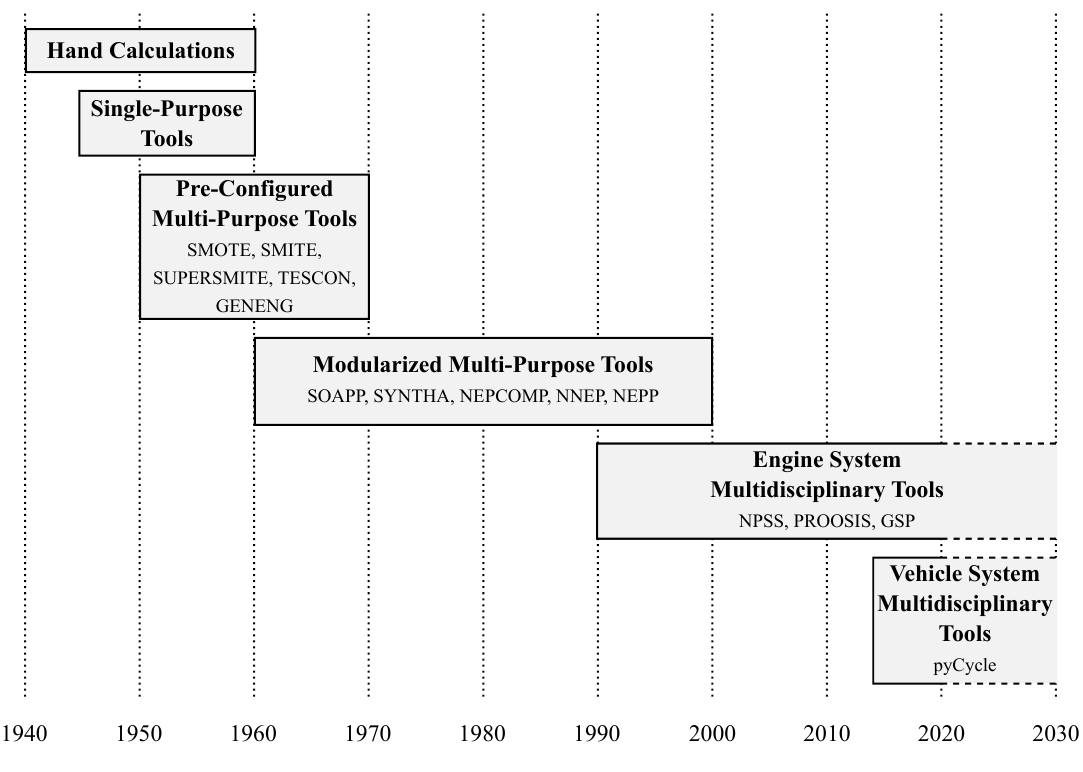
Figure 1. History of gas turbine cycle analysis eras with example